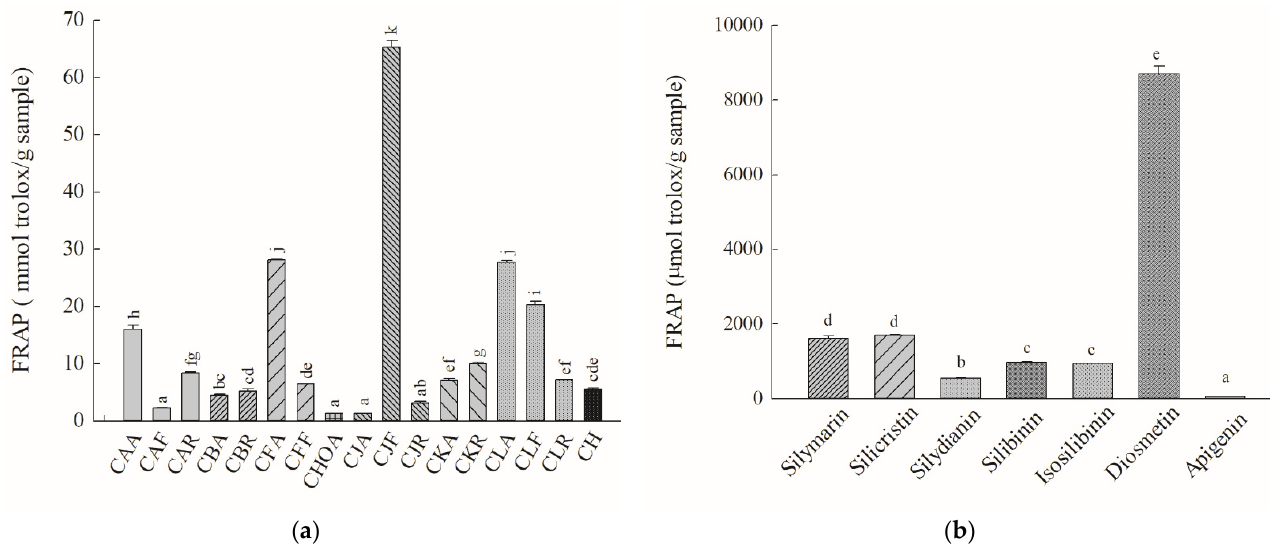
Figure 6. Reducing power of the methanolic standardized extracts of Cirsium species and Cirsii Herb. ( a ) The methanolic standardized extracts of Cirsium species and CH; ( b ) all ingredients of the methanolic standardized extracts of Cirsium species and CH. Data are expressed as means ± SD (n = 3). CAA, the aerial part of C. arisanense ; CAF, the flower part of C. arisanense ; CAR, the radix part of C. arisanense ; CBA, the aerial part of C. brevicaule ; CBR, the radix part of C. brevicaule ; CFA, the aerial part of C. ferum ; CFF, the flower part of C. ferum ; CHOA, the aerial part of C. hosokawae ; CJA, the aerial part of C. japonicum DC. var. australe ; CJF, the flower part of C. japonicum DC. var. australe ; CJR, the radix part of C. japonicum DC. var. australe ; CKA, the aerial part of C. kawakamii ; CKR, the radix part of C. kawakamii ; CLA, the aerial part of C. lineare ; CLF, the flower part of C. lineare ; CLR, the radix part of C. lineare ; CH, Cirsii Herb; FRAP, ferric reducing antioxidant power. Bars with different letters indicate statistical significances, p < 0.05.